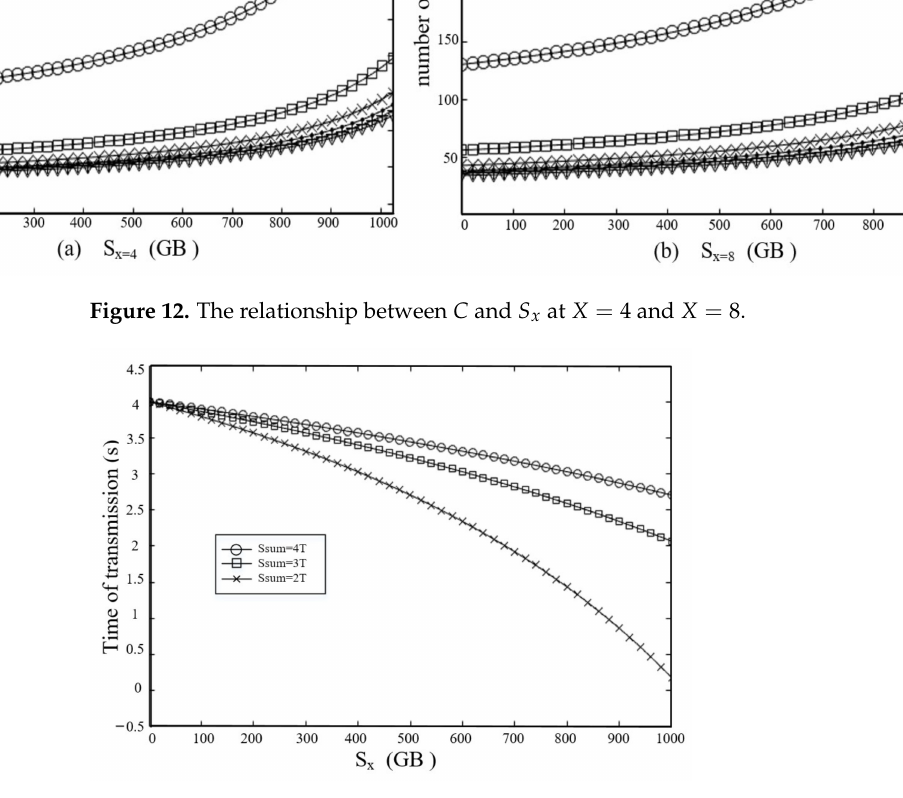
Figure 13. The relationship between T c and S x